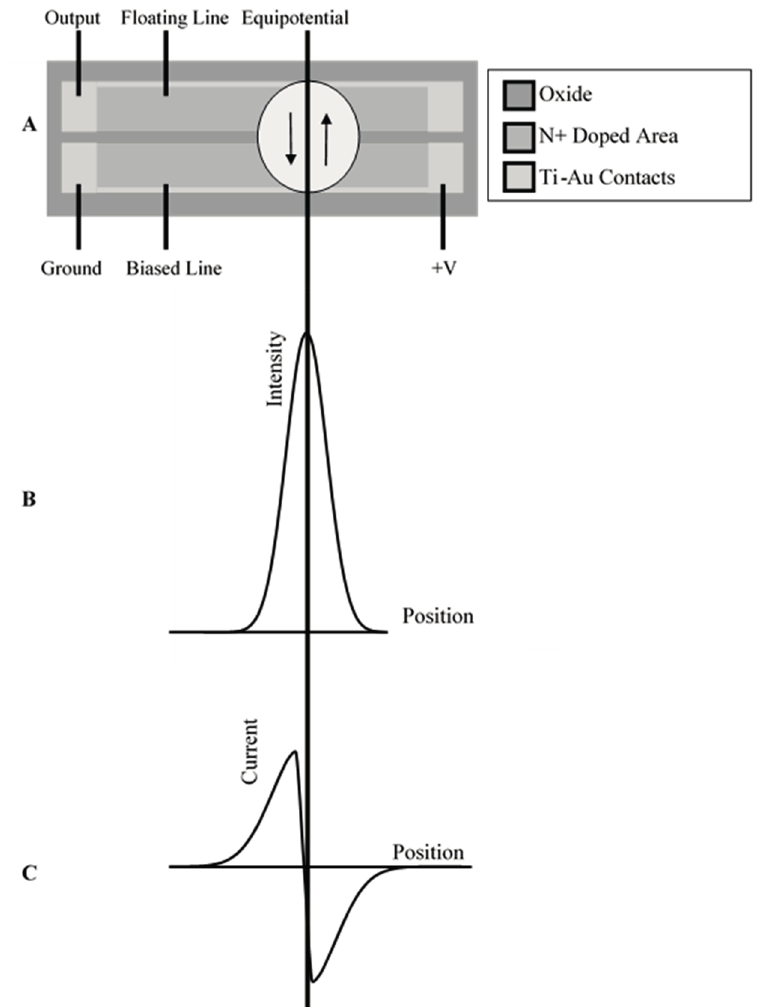
Figure 2. ( A ) Illustration of direction of current flow under illuminated light spot at the equilibrium position; ( B ) spatial distribution of the intensity of the light spot; ( C ) current produced in the device upon illumination in equilibrated state.